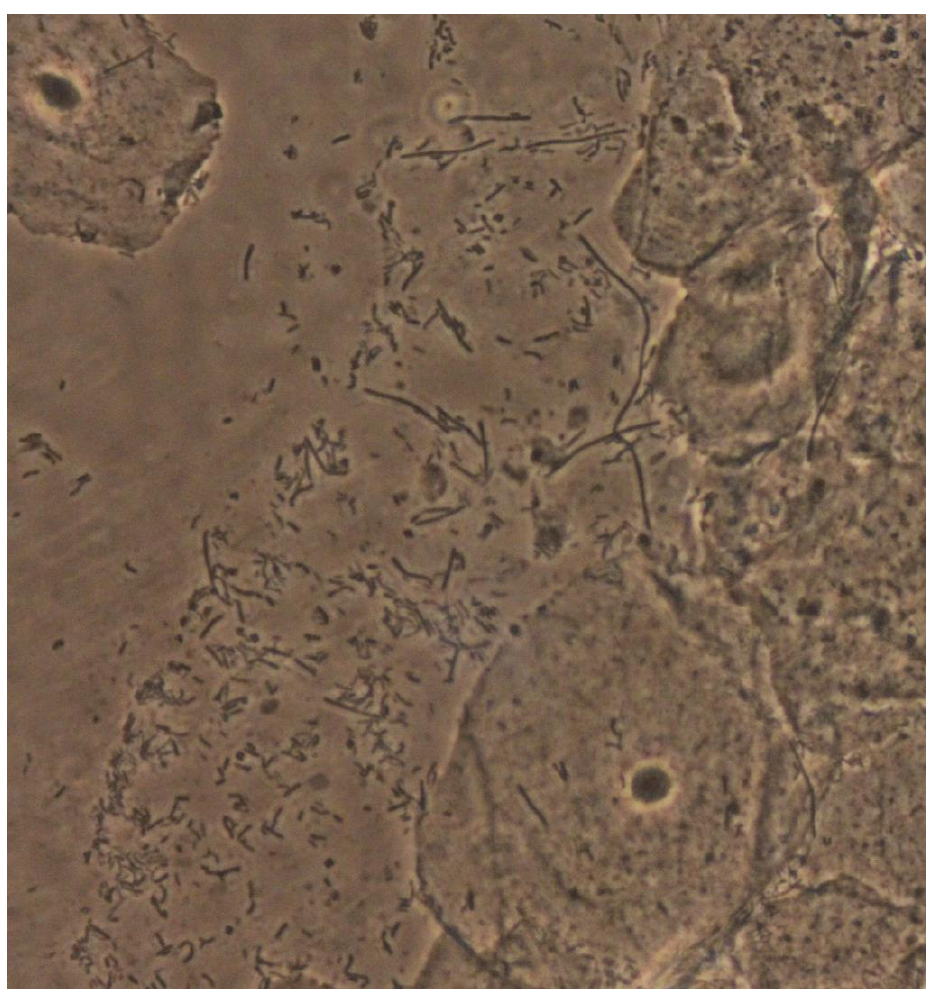
Figure 1. Leptothrix and normal background flora ( ×